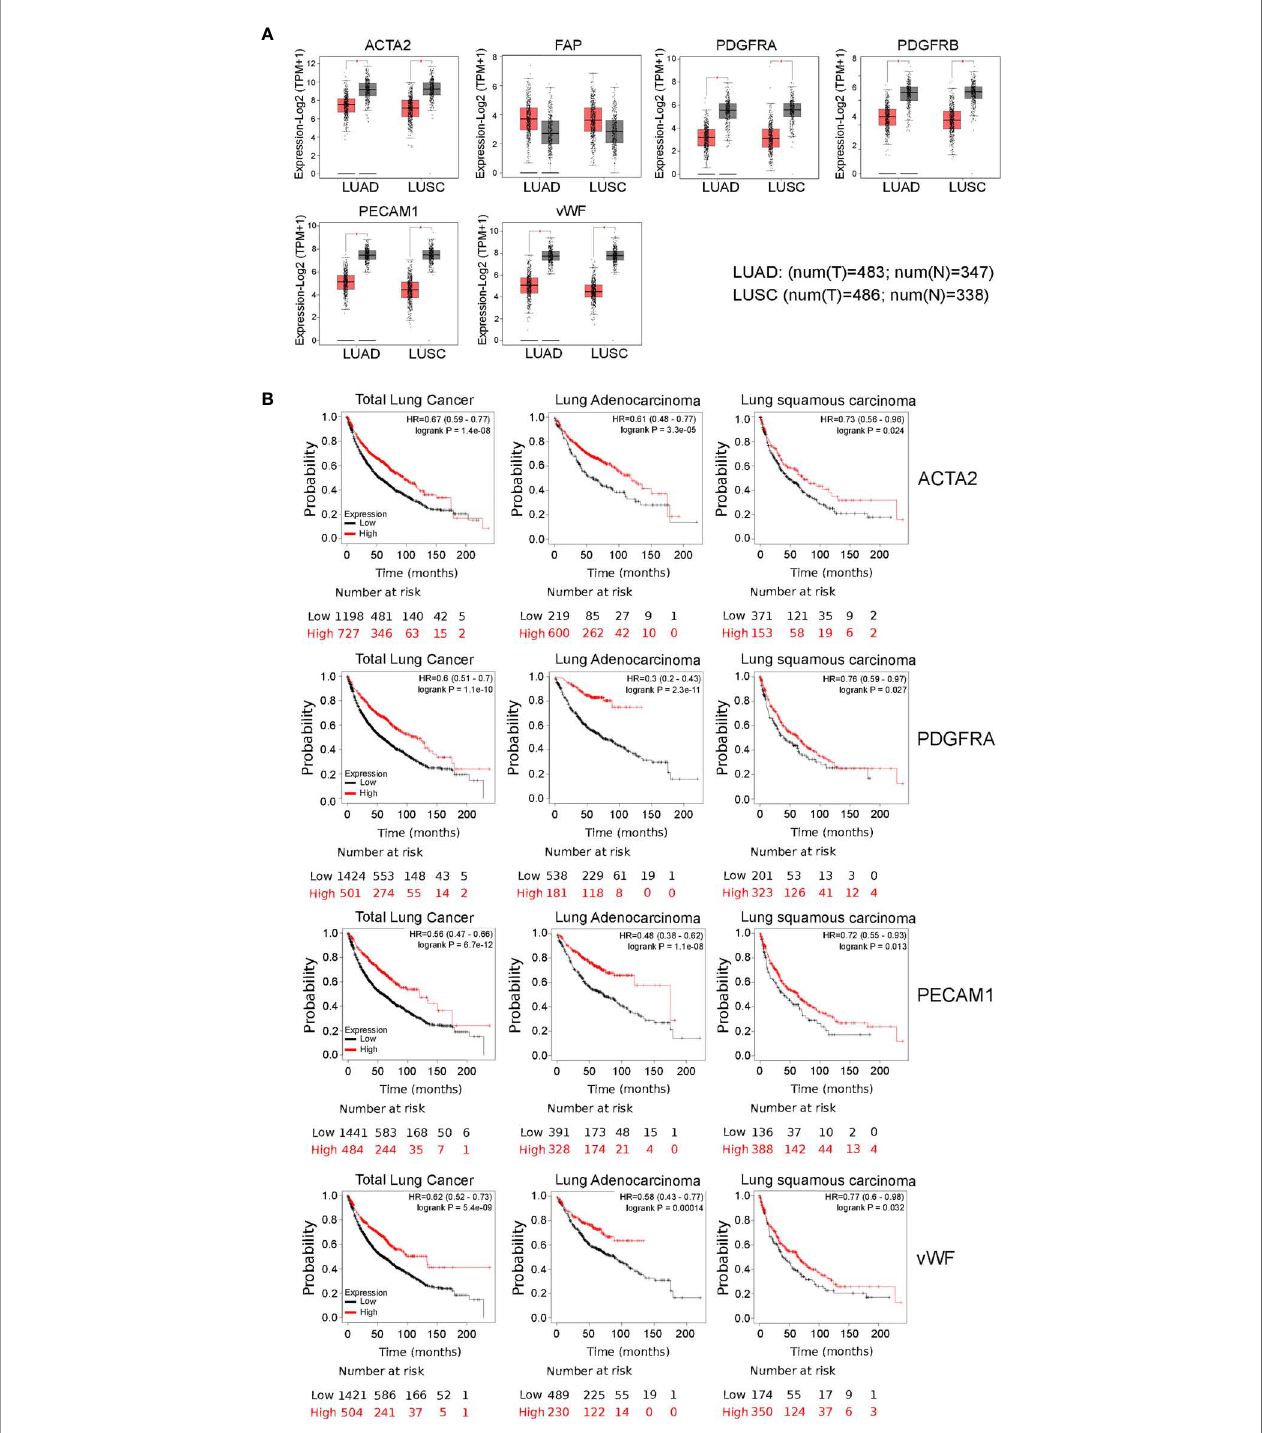
FIGURE 4 | Comparisons of the mRNA expression levels of cancer-associated fi bfroblasts and endothelial cells markers between normal (grey) and tumor tissues (red) (A) . Overall survival curve of each cancer-associated fi broblasts and endothelial marker shown to correlate with HEPH expression and produced by Kaplan – Meier website resource (B) . OS differences are compared between patients with high and low HEPH expression (grouped according to Auto select best cut-off). H, high expression; L, low